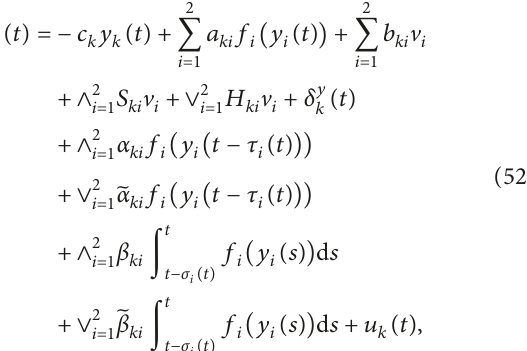
( t ) and y ( t ) for drive- 2 2